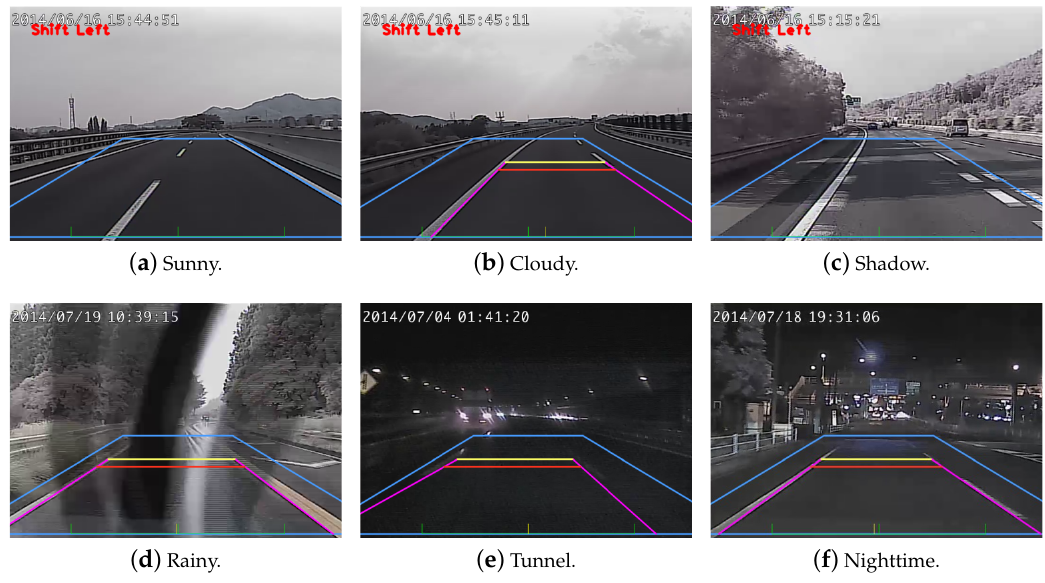
Figure 13. The results of lane change detection. The images contain a variety of illumination conditions such as sunny, cloudy, and at night.